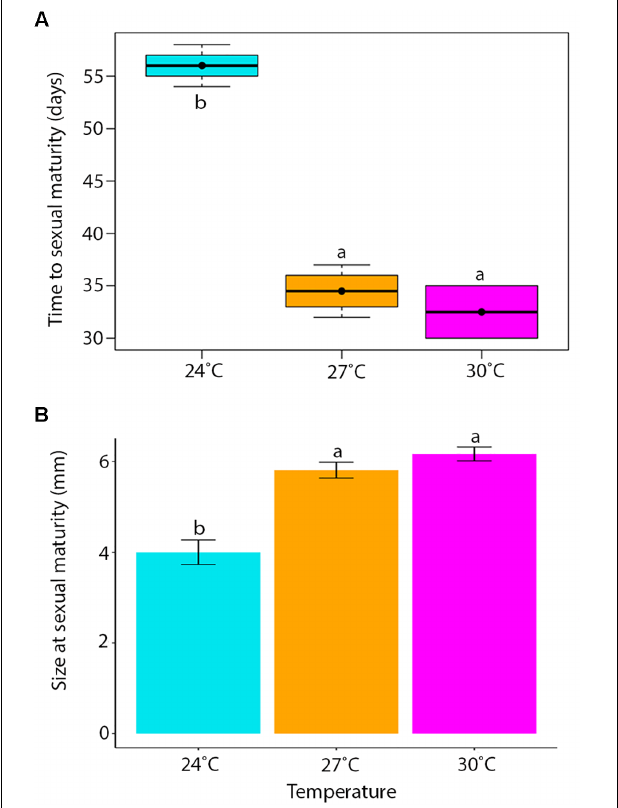
FIGURE 4 | (A) The time for hatchlings to reach sexual maturity (error bars = min. and max. values, boxes = lower and upper quartiles, line = median, and dot = mean). (B) Mean body length ( ± SE) of individuals at sexual maturity. Treatment boxes and bars with the same letter are not significantly different from each other ( p >